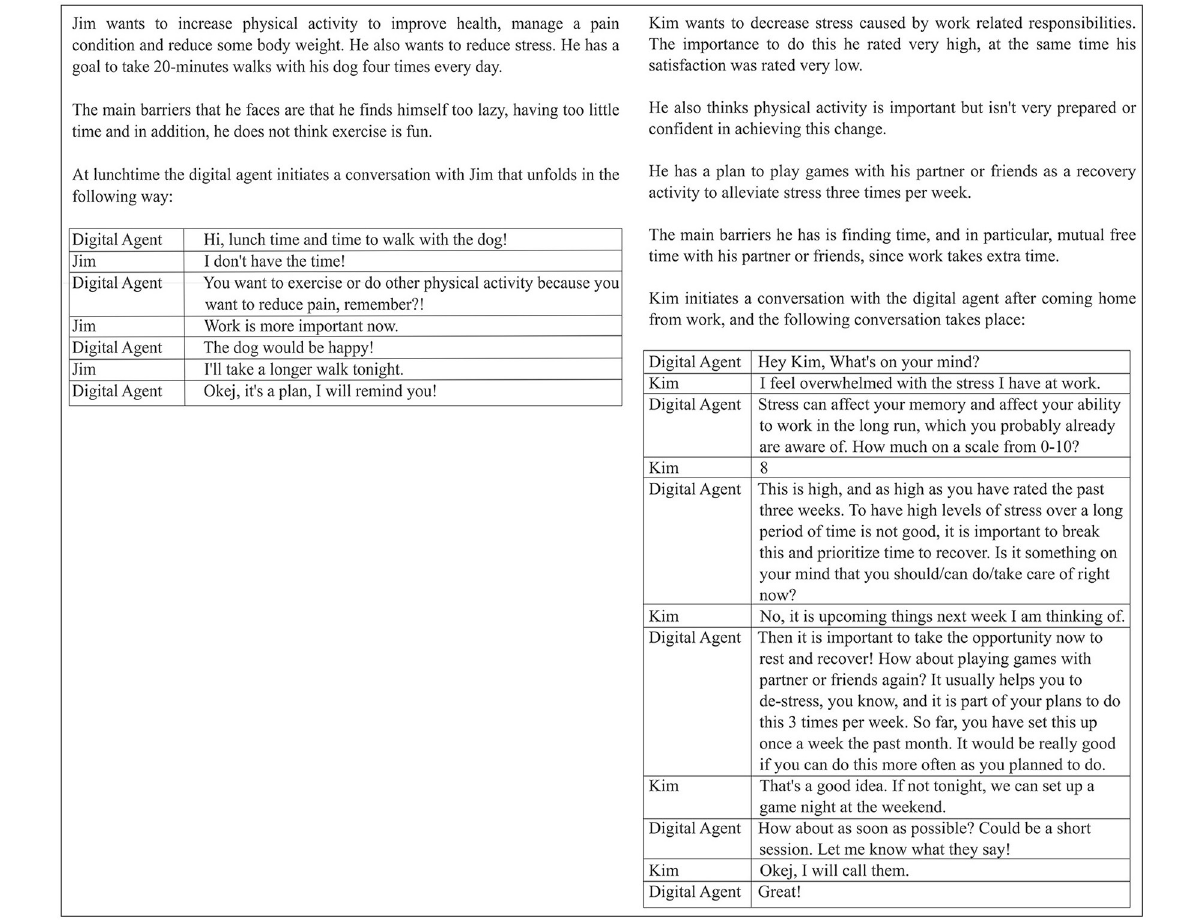
Classification of Function, Ability, and Health (ICF), 3 which is extended with specific and relevant sub-concepts in the class Personal Factors and in the class Activity and Participation . Other classes are Body Function and Structures , and Environment , containing social relations and support. ICF is complemented with the class Diseases and Syndromes for capturing medical and health